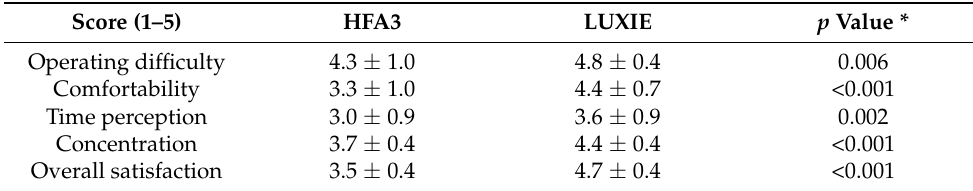
Table 1. Analysis of the score between HFA3 and LUXIE in user survey ( n =